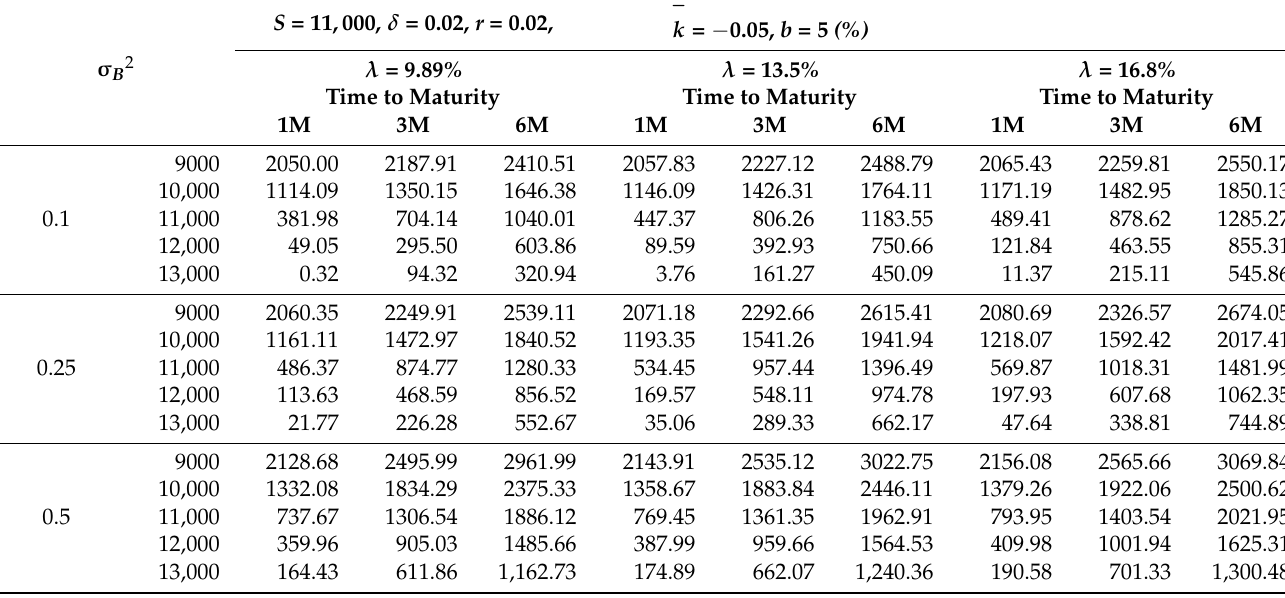
Table 3. Calculating Bitcoin Call Option Valuation with Bates